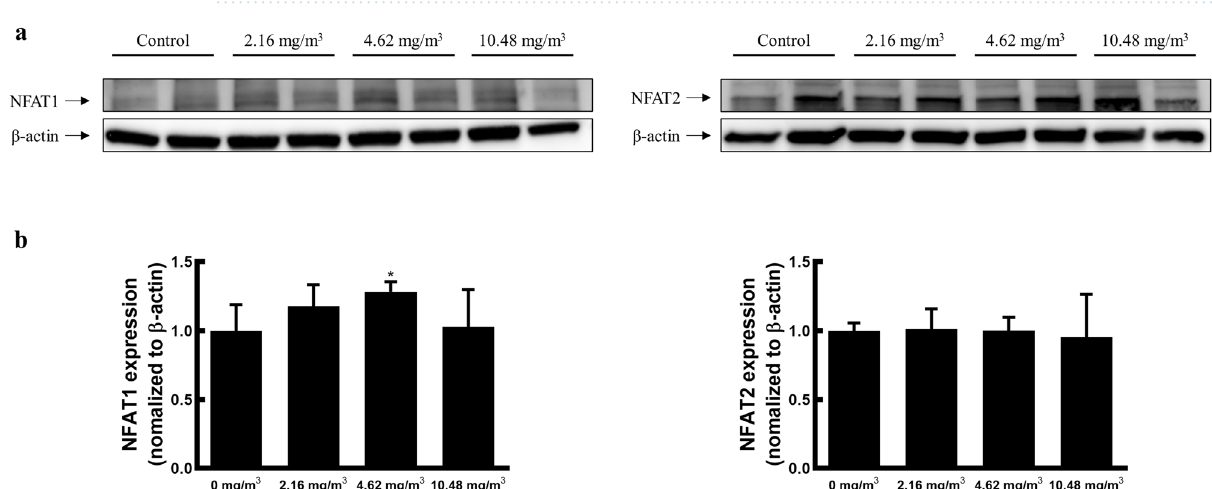
Figure 4. Expression of NFAT1 and NFAT2 in the spleen after FA exposure. ( a ) NFAT1 and NFAT2 expression assessed via western blotting. Gel was cut prior to transfer onto PVDF membranes, and each band from the same gel was grouped together. The original raw data are shown in Supplementary information. ( b ) Densitometric analysis of the blots. The target protein expression levels were normalised to β-actin expression. Data are presented as the mean ± SD from two independent experiments ( n = 2 minipigs/group). * p < 0.05. FA